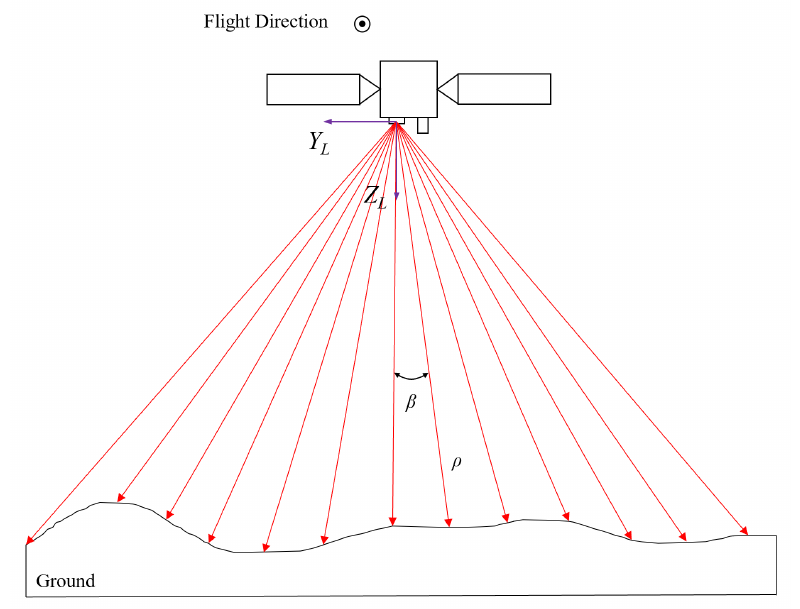
Figure 4. Earth observation by LiDAR. The geometric meaning of the above matrices is shown in Figure 5.